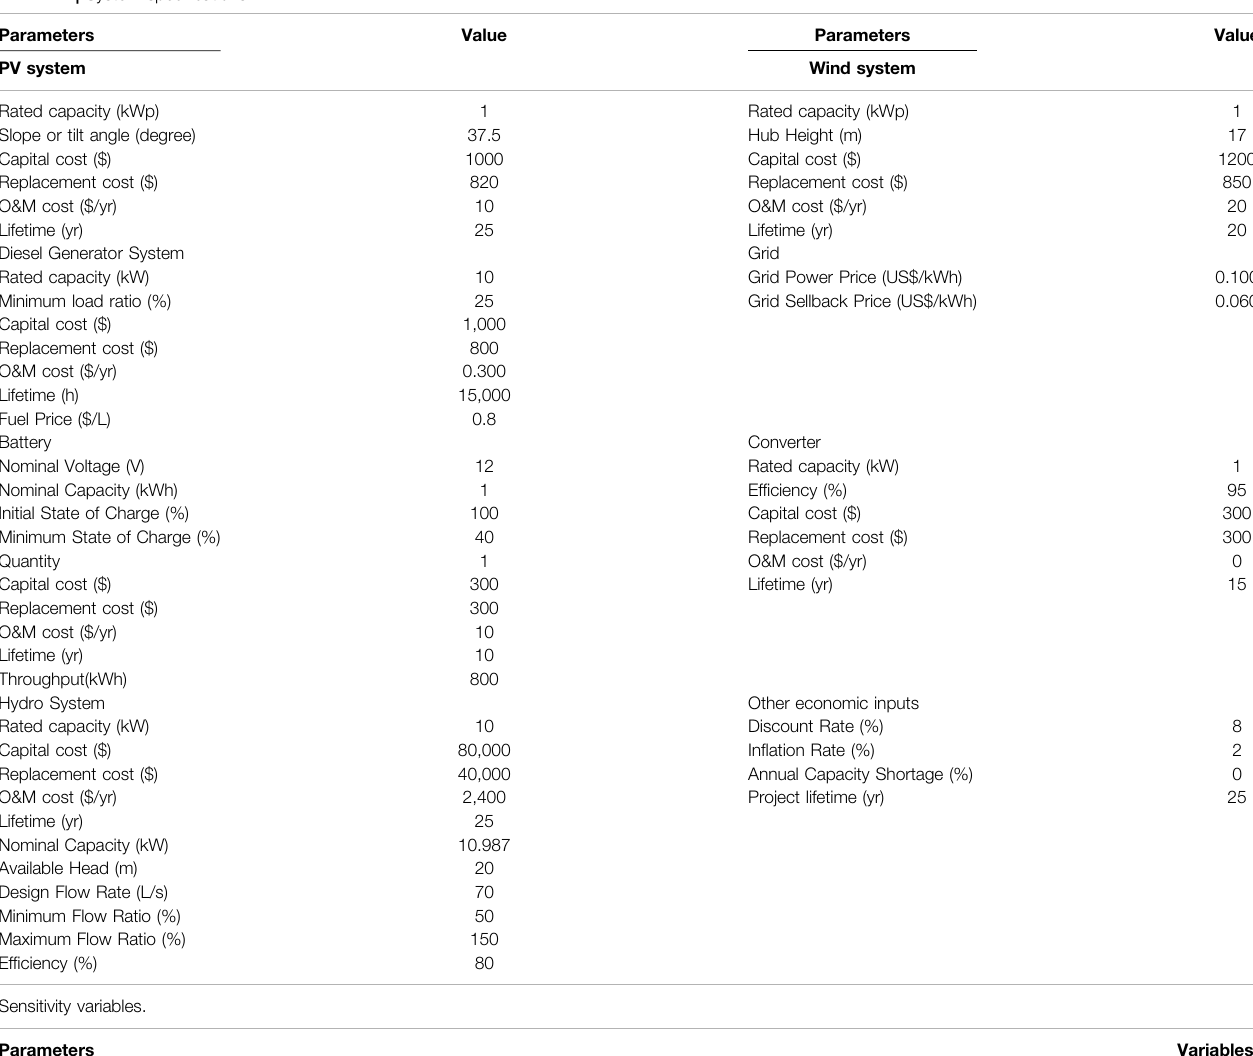
TABLE 2 | System speci fi